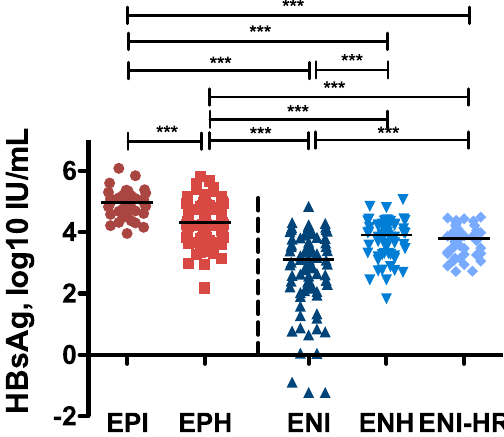
Figure 1. qHBsAg titers in chronic HBV. HBsAg titers in different phases of chronic HBV infection were quantified by using Abbott ARCHITECT assay (red: HBeAg positive, blue: HBeAg negative). Mann-Whitney U test was used for comparison of means.